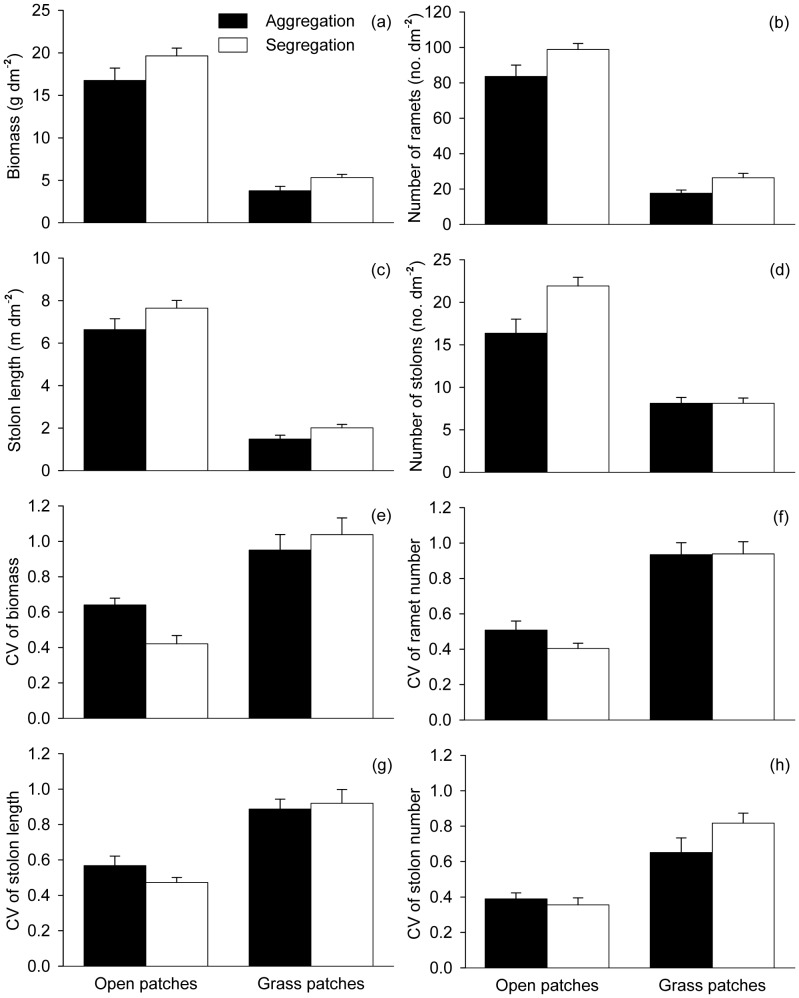
Effects of patch type (open patches vs. grass patches) and ramet aggregation (aggregation vs. segregation) on the growth (a–d) and size variation (e–h) of the Hydrocotyle vulgaris populations.Error bars show +1 SE.